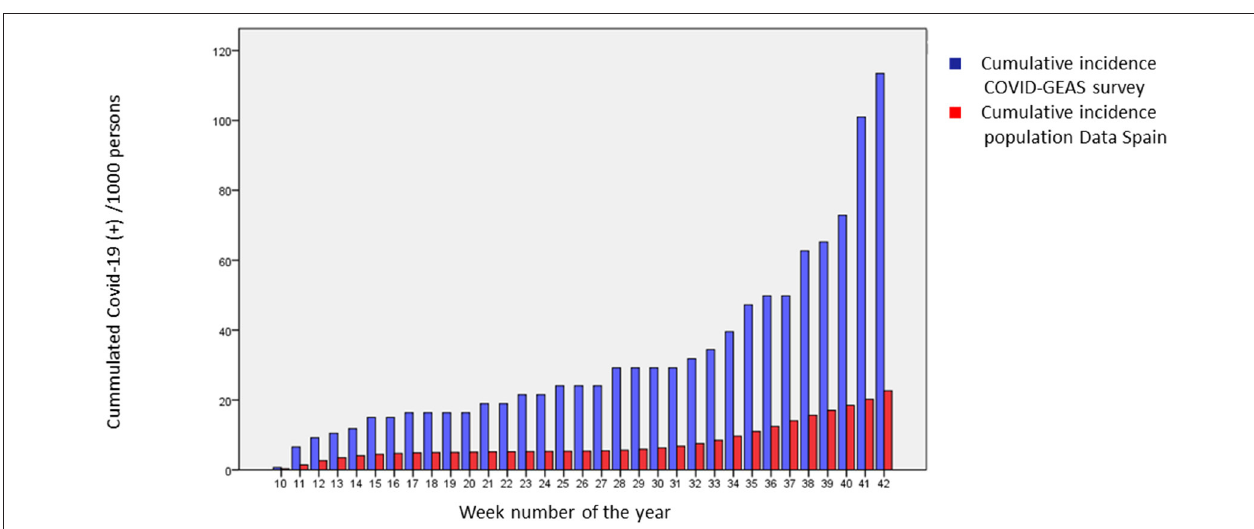
FIGURE 1 | Comparative between cumulative incidence of Spain and COVID-GEAS survey. The proportion of patients with confirmed SARS-CoV-2 infection in our cohort was compared to those reported for the general population of Spain, using the Pearson test.